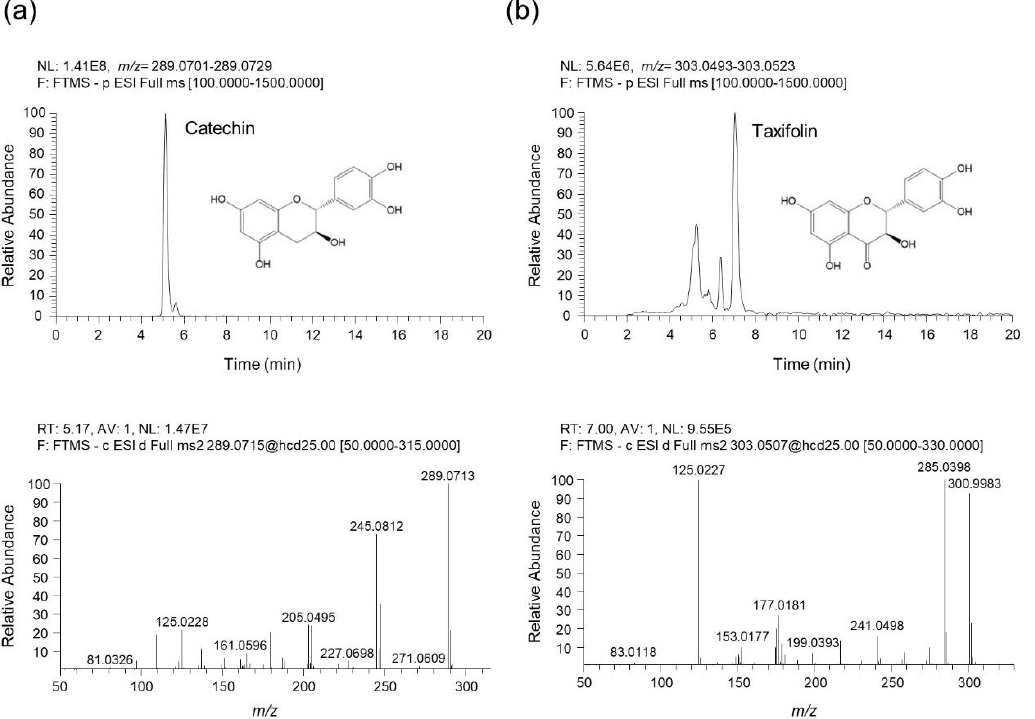
Figure 8. UHPLC-UV-HRMS analysis of catechin and taxifolin in QAE. ( a ) The extracted ion chro- matogram (EIC) of catechin identified in QAE (upper chromatogram), and the MS/MS spectrum of catechin (below spectrum). ( b ) The EIC of taxifolin identified in QAE (upper chromatogram), and the MS/MS spectrum of taxifolin (below spectrum). All components were detected in negative ion mode.